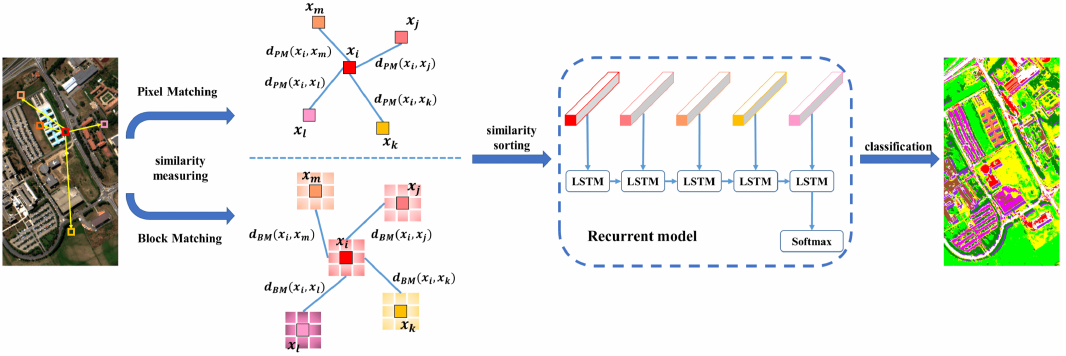
Figure 1. Architecture of the proposed